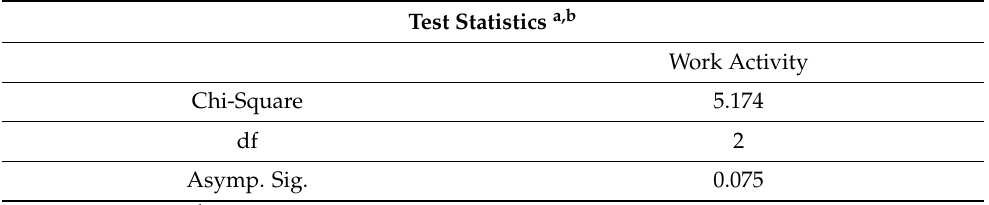
Table 6. Kruskal–Wallis test results for work